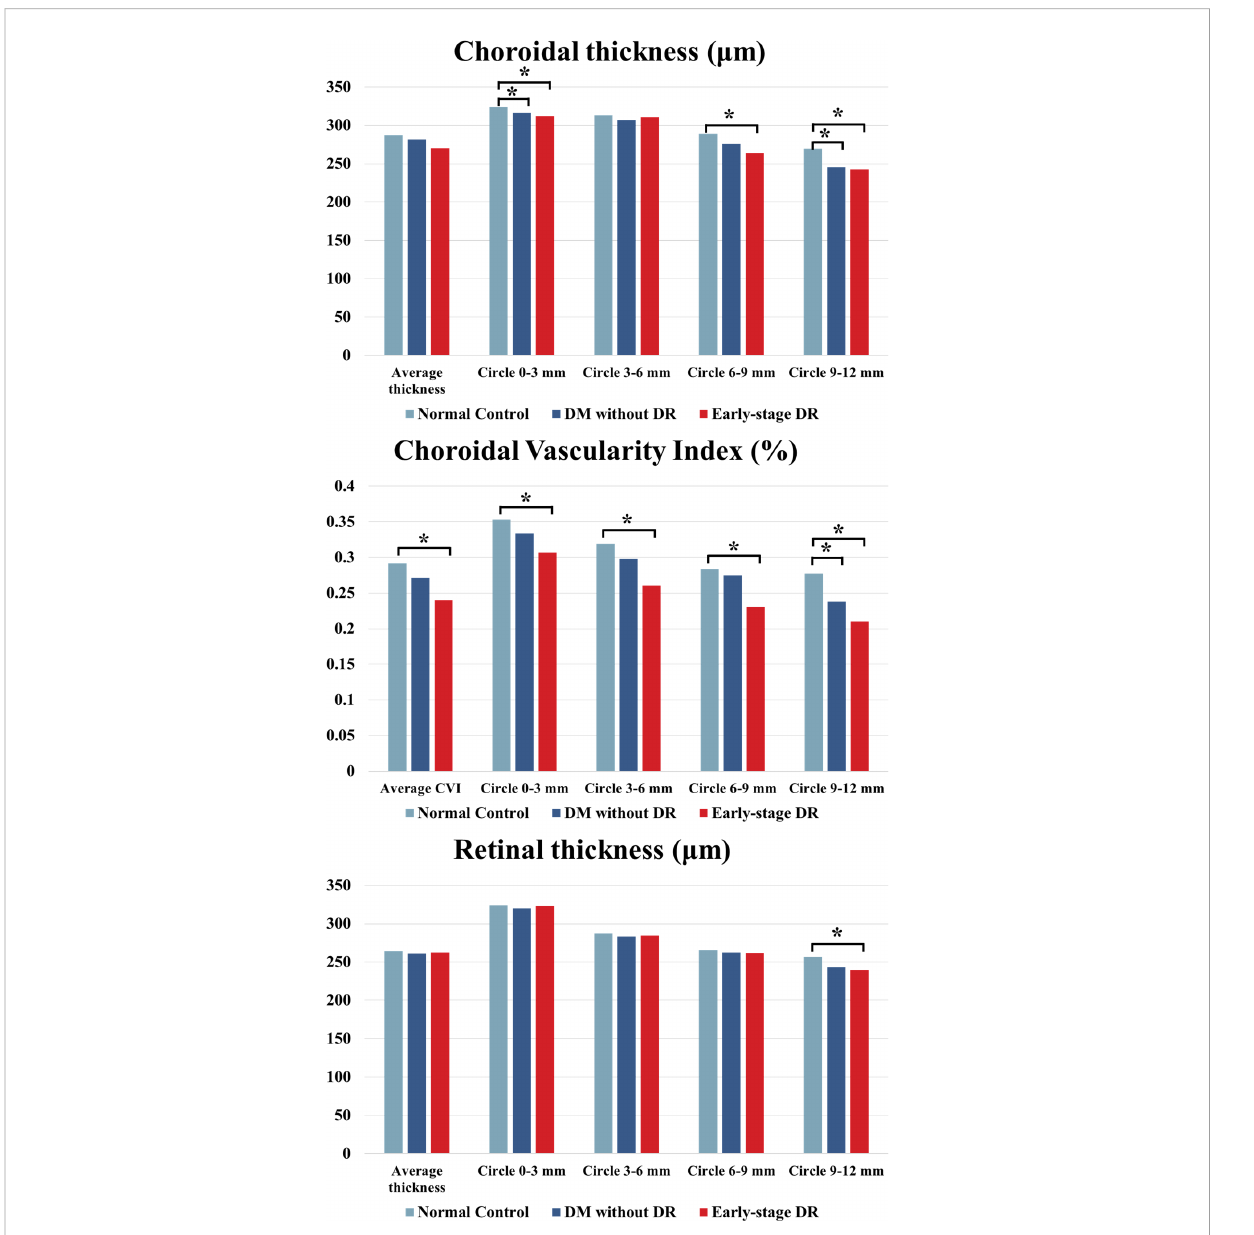
FIGURE 2 ChT, CVI and CMT comparison of patients with early-stage DR, diabetes mellitus without ophthalmoscopic signs of DR and normal control subjects of the control group. * indicates a statistically signi fi cant difference (p <